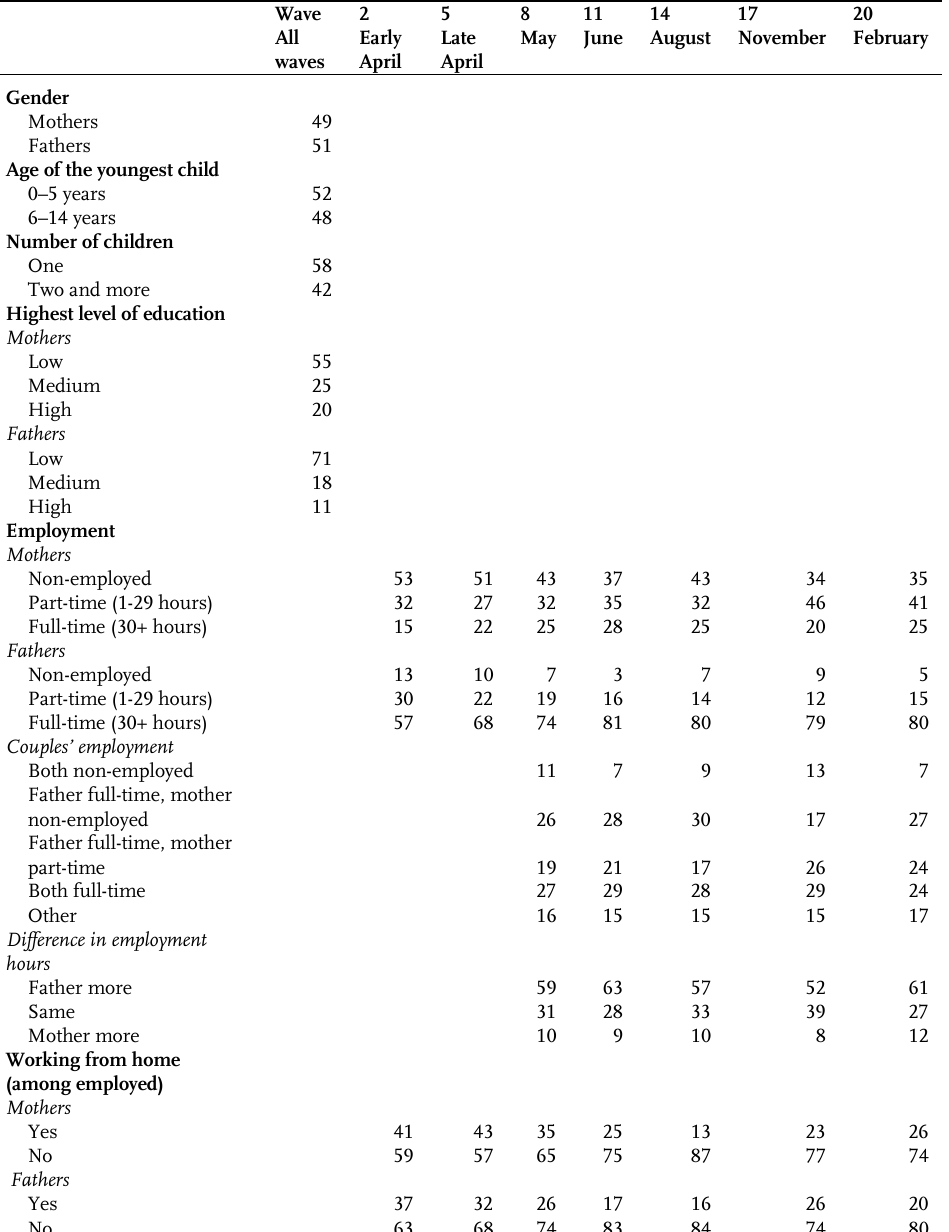
Table A2 : Distribution of independent variables, in